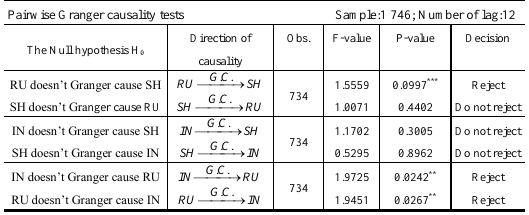
Table 2 Results for Granger causality tests Pairwise Granger causality tests Sample:1 746; Number of